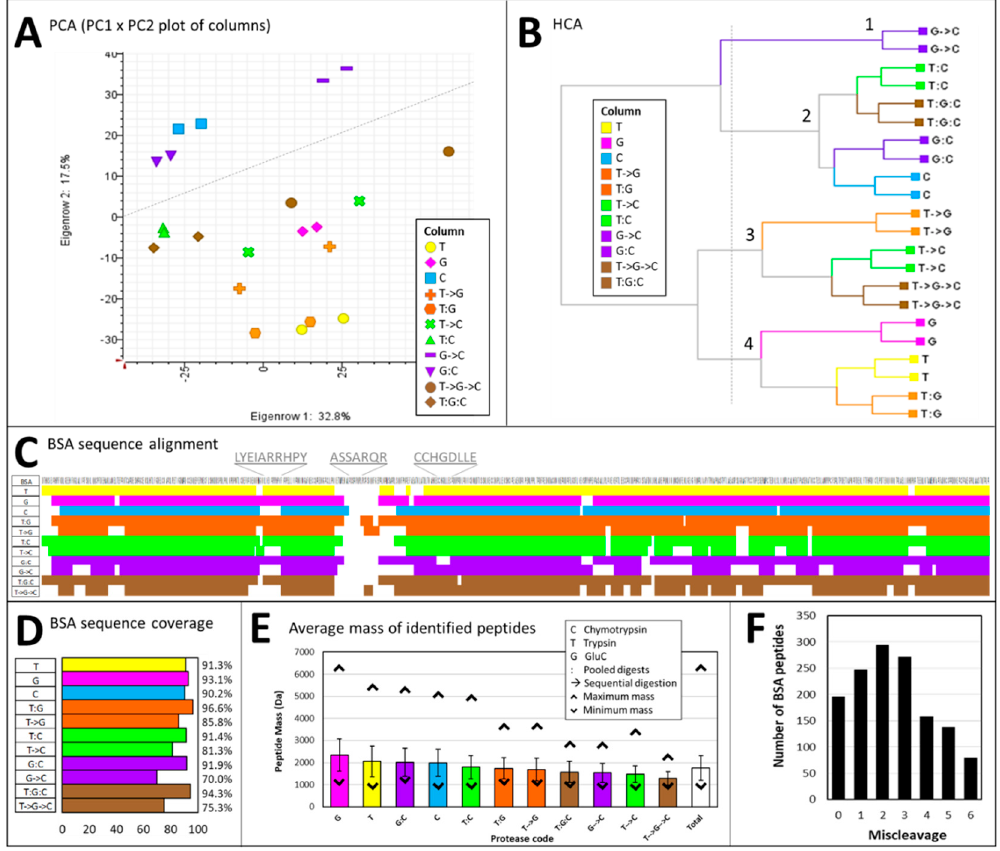
Figure 2. Protease digestion tests on bovine serum albumin (BSA). ( A ) Principal component analysis (PCA) of the BSA identified peptides. ( B ) Hierarchical clustering analysis (HCA) of the BSA identified peptides. ( C ). Identified peptides aligned onto BSA AA sequence of the mature protein. ( D ). BSA sequence coverage achieved using the various proteases on their own or in combination. ( E ) Average mass (Da) of BSA peptides resulting from the three proteases acting on their own, sequentially, or pooled; vertical bars denote standard deviation (SD). ( F ) Distribution of number of identified peptides according to the number of miscleaveages. Downward arrowhead (v) denotes the minimum peptide mass and upward arrowhead (^) denotes the maximum peptide mass.